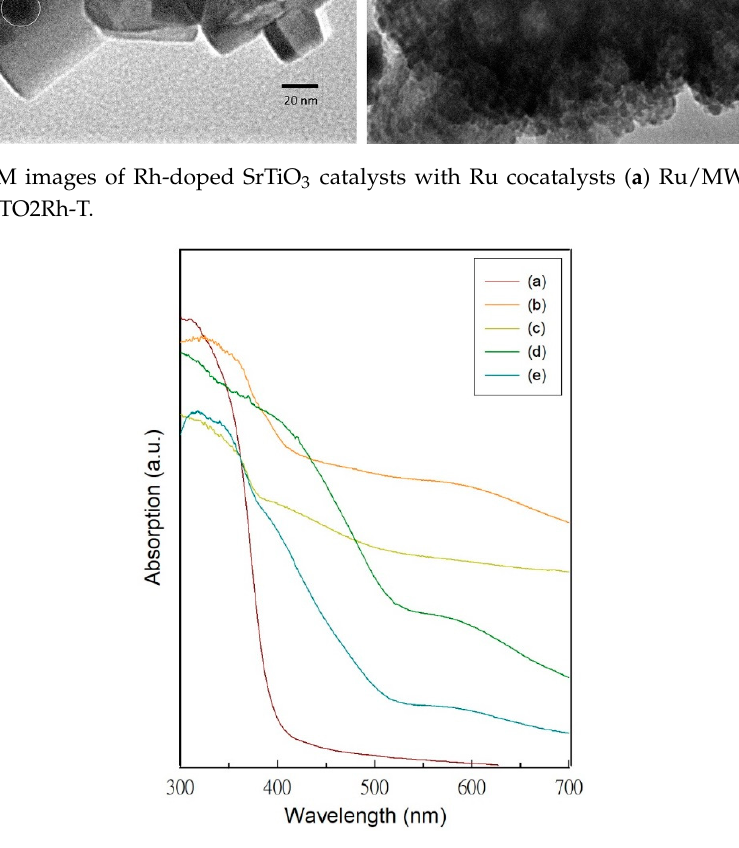
Figure 5. UV-vis spectra of Rh-doped SrTiO 3 catalysts ( a ) MW-STO-A ( b ) SS-STO2Rh ( c ) HT-STO2Rh ( d ) MW-STO2Rh-A ( e ) MW-STO2Rh-T.